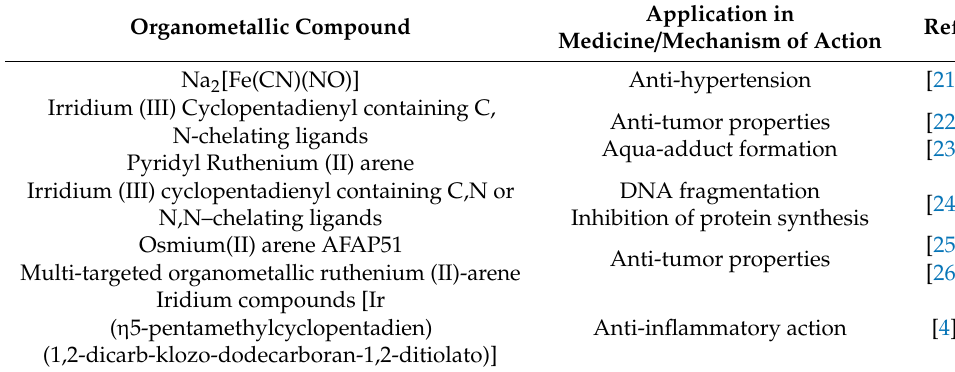
Table 1. Therapeutic application of selected organometallic